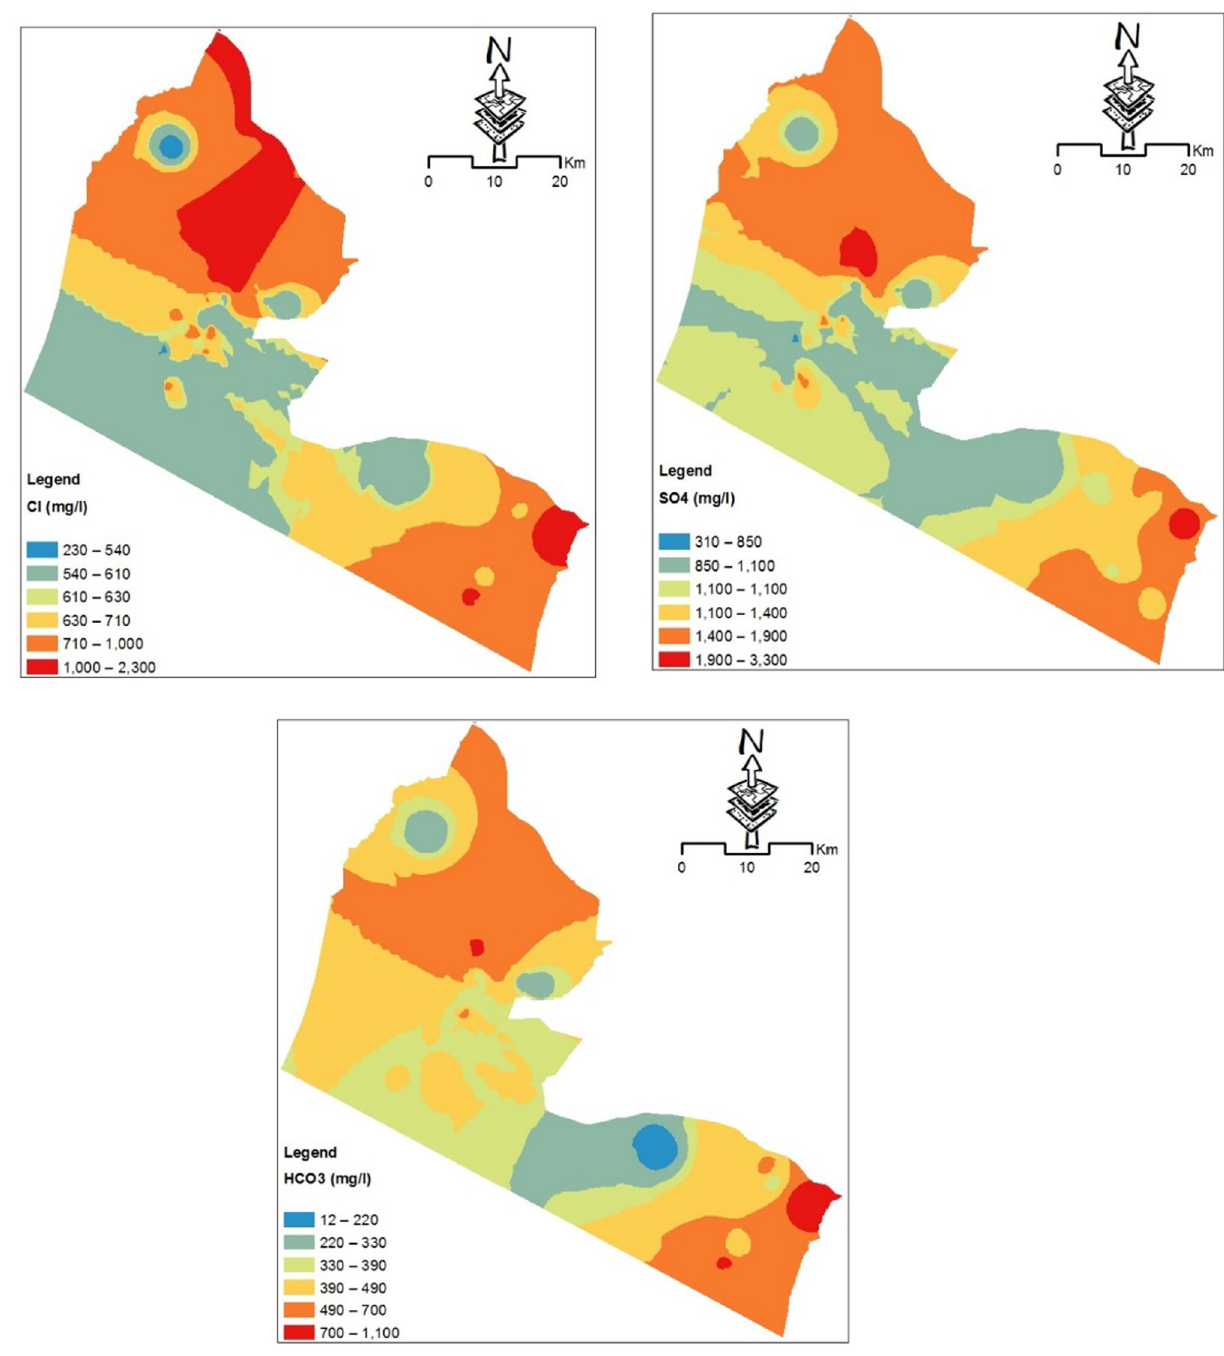
Fig. 7 Spatial distribution pattern of anions (Cl - , SO 42 - , HCO 3 - )